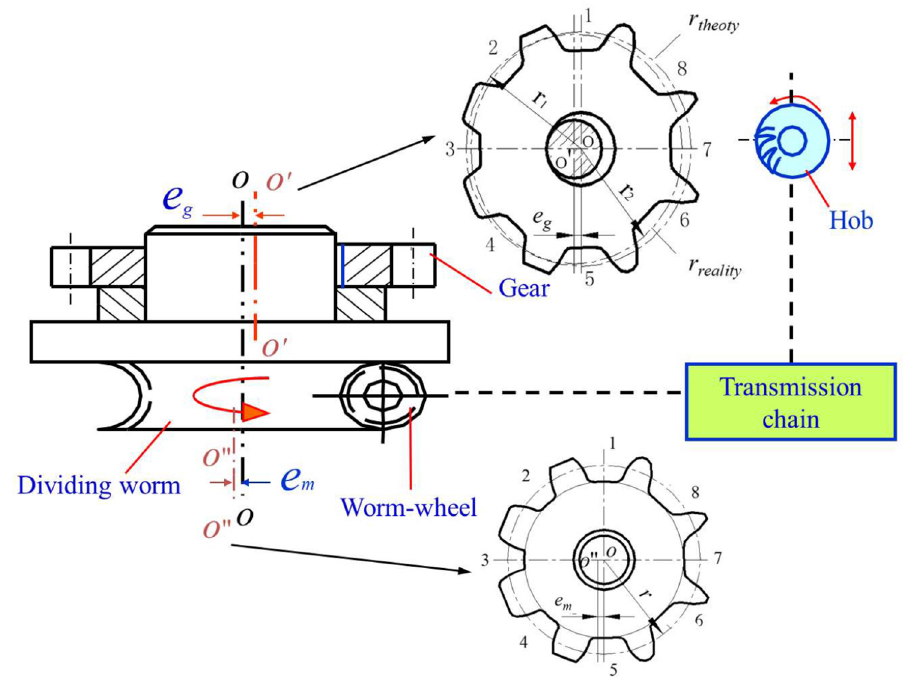
Fig. 2. Gears ’ errors in manufacturing